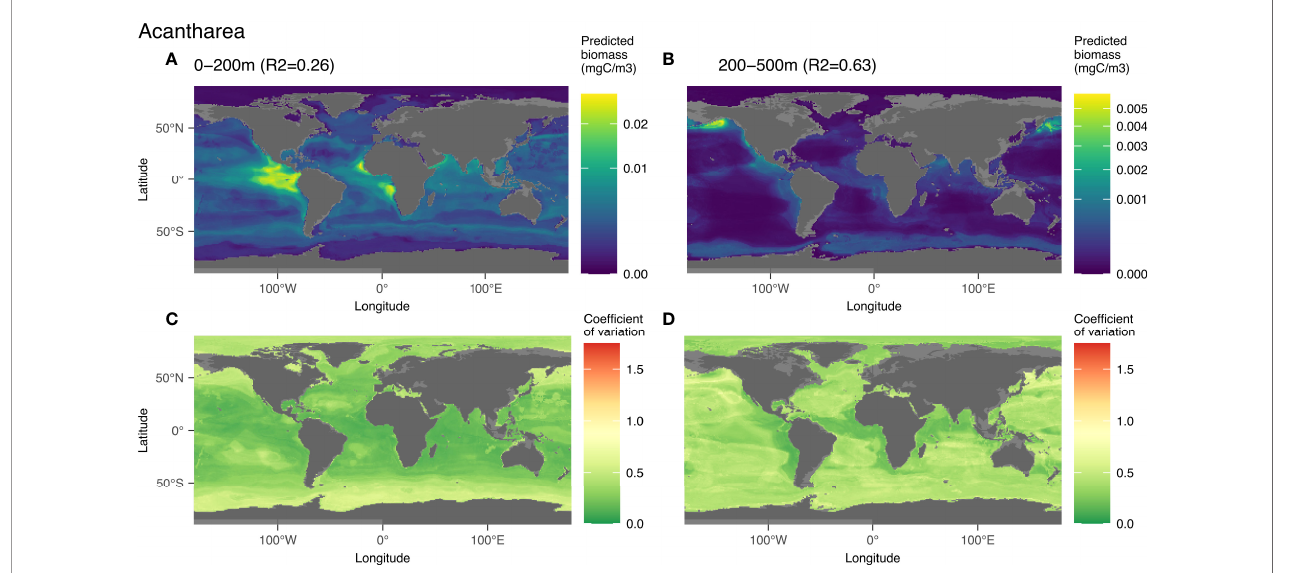
FIGURE 9 | Map of the mean biomass (color scale is log-transformed) of Acantharea as predicted by the model on 0-200 m (A) , 200-500 m data (B) , as well as the coef fi cient of variation for the 0-200 m model (C) and 200-500 m one (D) . The color scale for the coef fi cient of variation has the same range for Figures 5 – 9